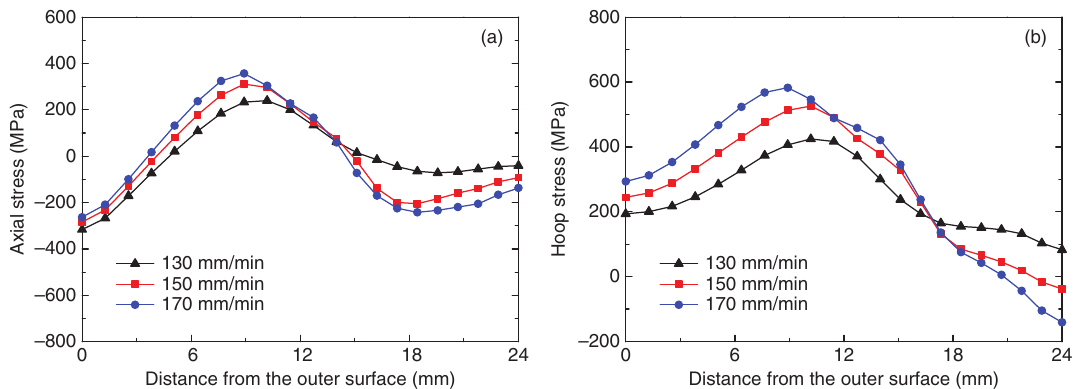
Figure 7: Residual stresses distributions at different arc travelling speeds along path 2: axial stress (a), hoop stress (b).